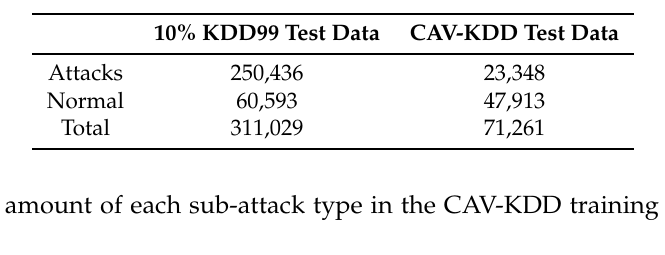
Table 5. Amount of normal and attack data in the testing data